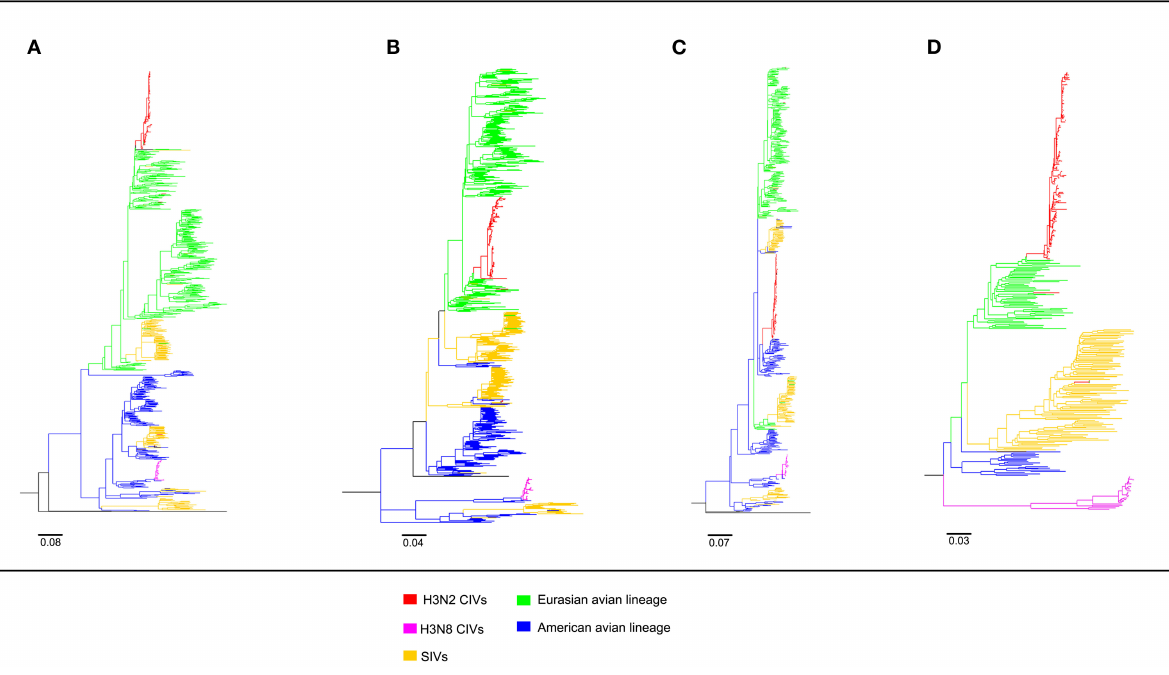
FIGURE 2 | Maximum likelihood trees of segment 1-4 of H3N2 CIVs. (A) PB2; (B) PB1; (C) PA; (D) HA. Colored branches represent distinct lineages. H3N2 CIVs: red, H3N8 CIVs: purple, SIVs: yellow, Eurasian avian lineage: green, and American avian lineage: blue. The bars are drawn to scale.